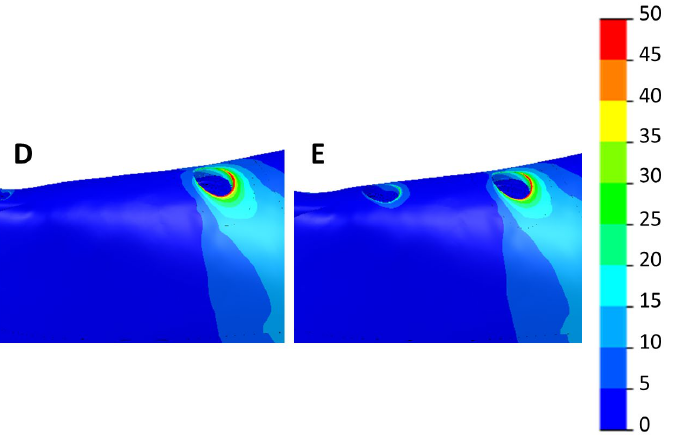
Figure 13. Distribution of the von Mises stresses (MPa) in scenarios A-1, A-2, A-3, B and C.